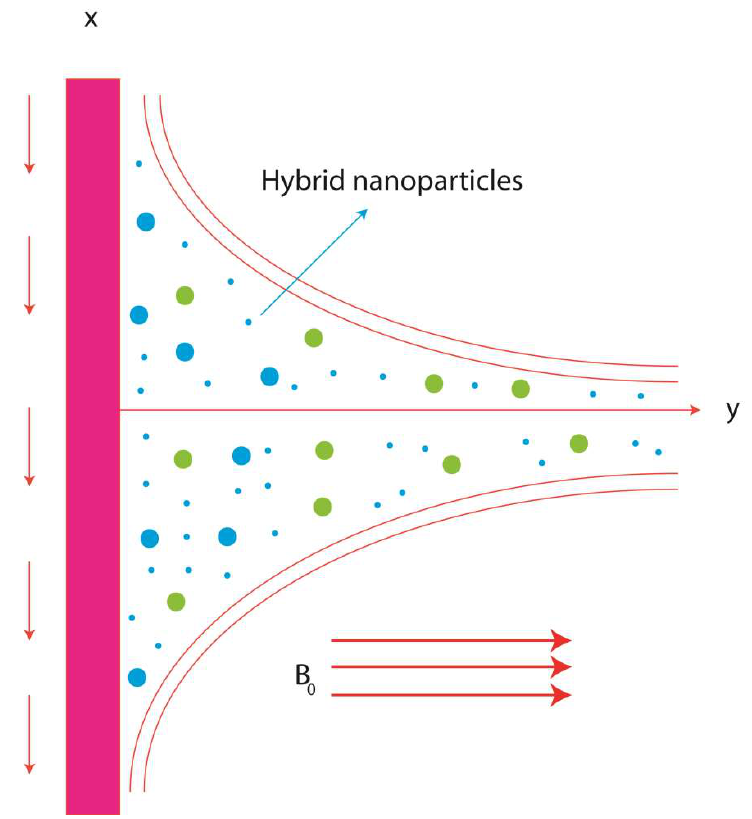
Figure 1. The physical arrangement and coordinates